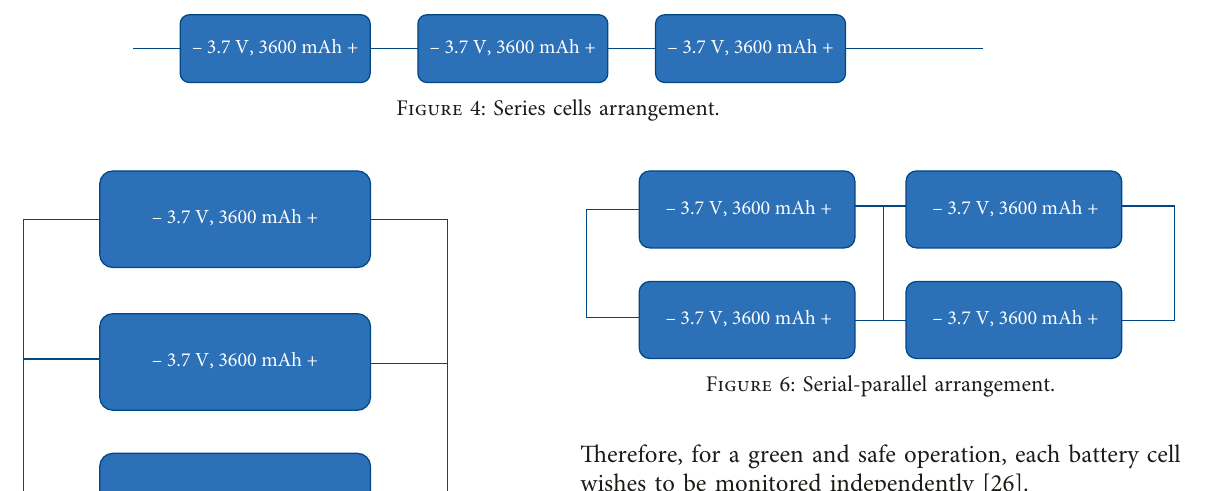
Figure 4: Series cells arrangement.